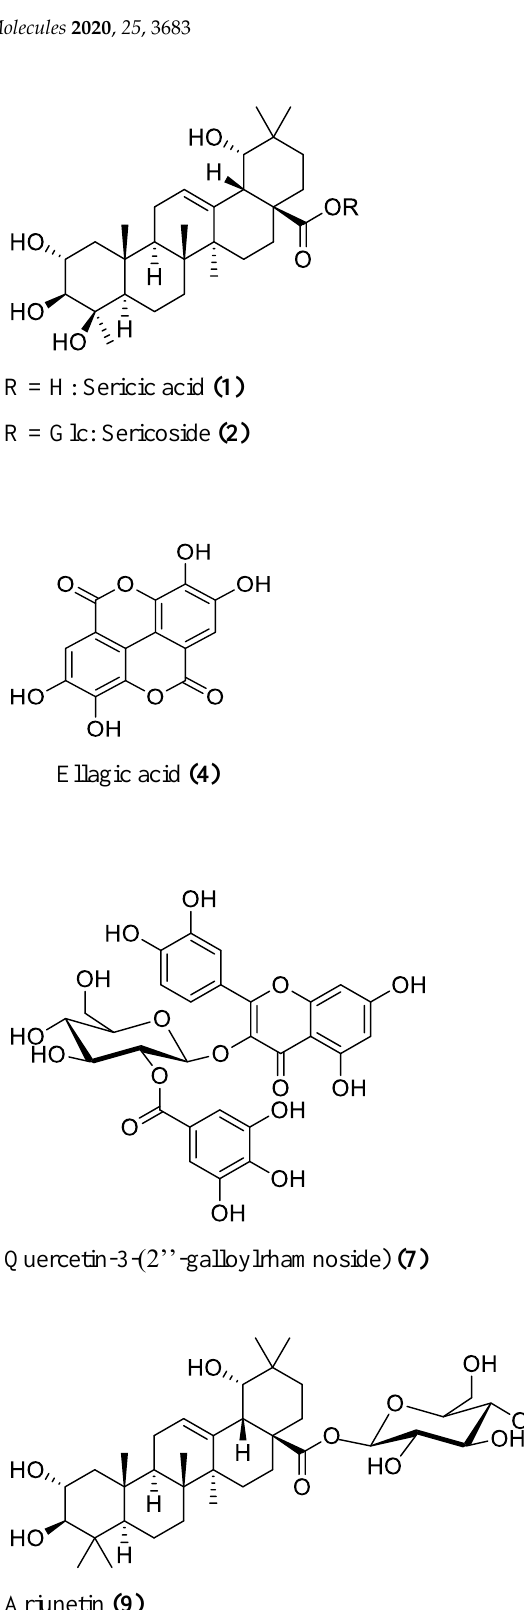
Figure 2. Compounds ( 1 – 9 ) isolated from dichloromethane:methanol crude extract of T. sericea root bark. The compound yielding a fragment at m / z 469 (Rt 3.72 min) was obtained as white crystals from Fraction 1 and identified as sericic acid ( 1 ) on the basis of its spectral data, corresponding to those reported in literature [26,29–31]. The molecular ion ( m / z 527.336) obtained from the